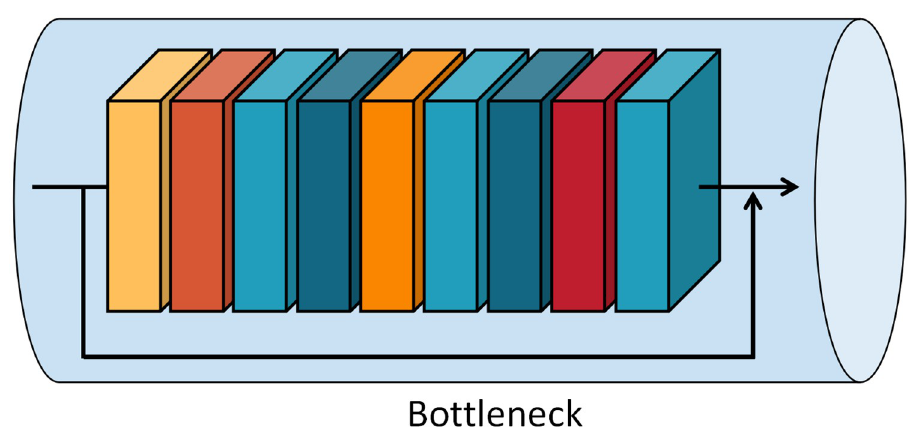
Fig 4. Diagram of bottleneck